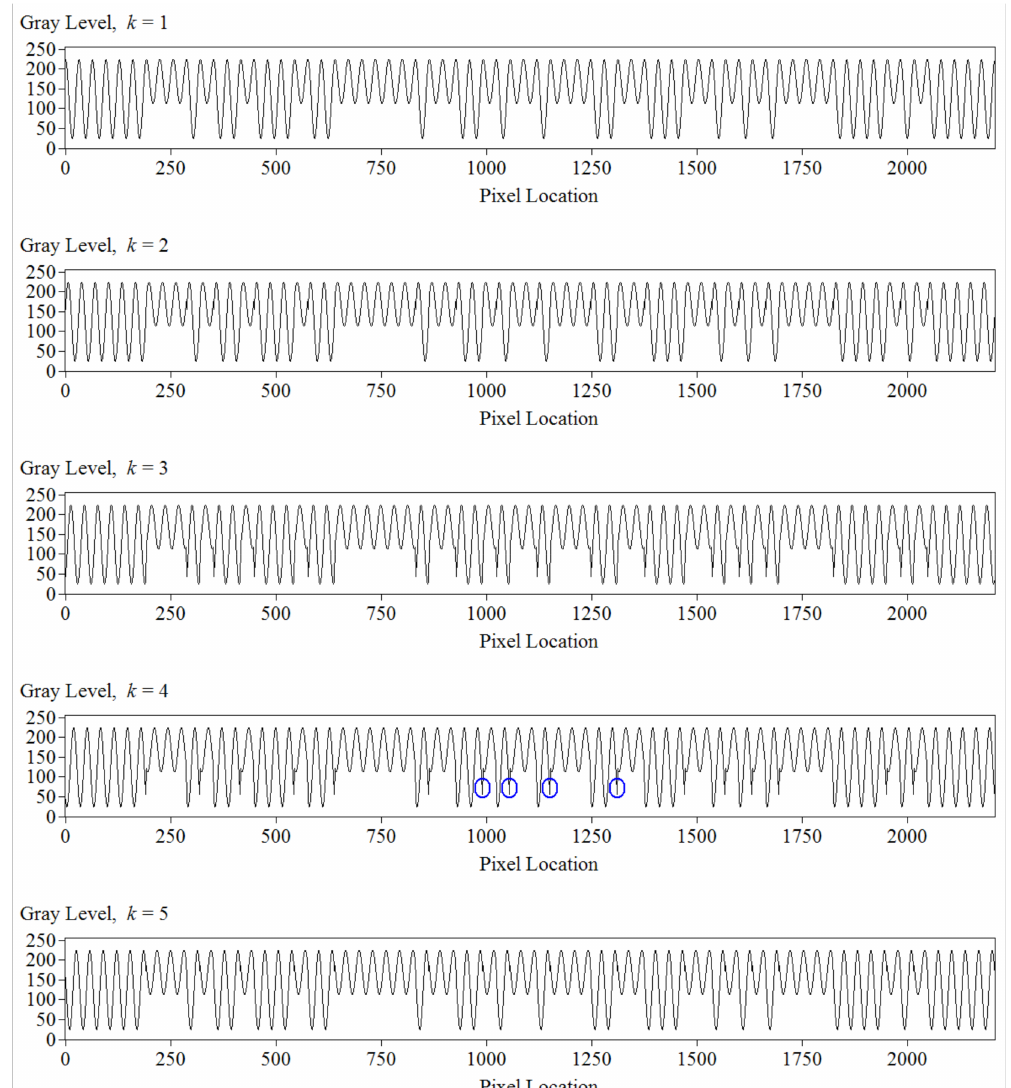
Figure 3. One-dimensional gray-level distributions of the five encoded patterns.